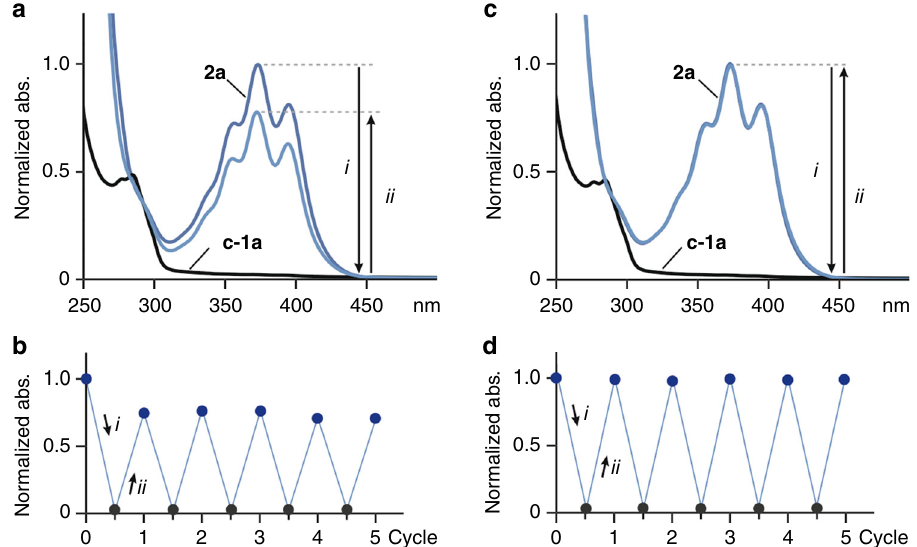
Fig. 4 UV-visible study of the reversible assembly – disassembly of the nanocapsule. a UV-visible spectral changes (H 2 O, room temperature, 1.0 mM based on o-1a ) of 2a upon light irradiation ( i ) at 380 nm for 5 min and then ( ii ) at 287 nm for 25 min (using a fl uorescence spectrophotometer (950 V)) and b disassembly – assembly cycles of 2a , monitored by UV-visible spectroscopy (plots of the absorption intensities at 373 nm). c UV-visible spectral changes (H 2 O, room temperature, 1.0 mM based on o-1a ) of 2a upon ( i ) light irradiation at 380 nm for 5 min and then ( ii ) heating at 160 °C for 30 min and d disassembly – assembly cycles of 2a , monitored by the UV-visible spectroscopy (373